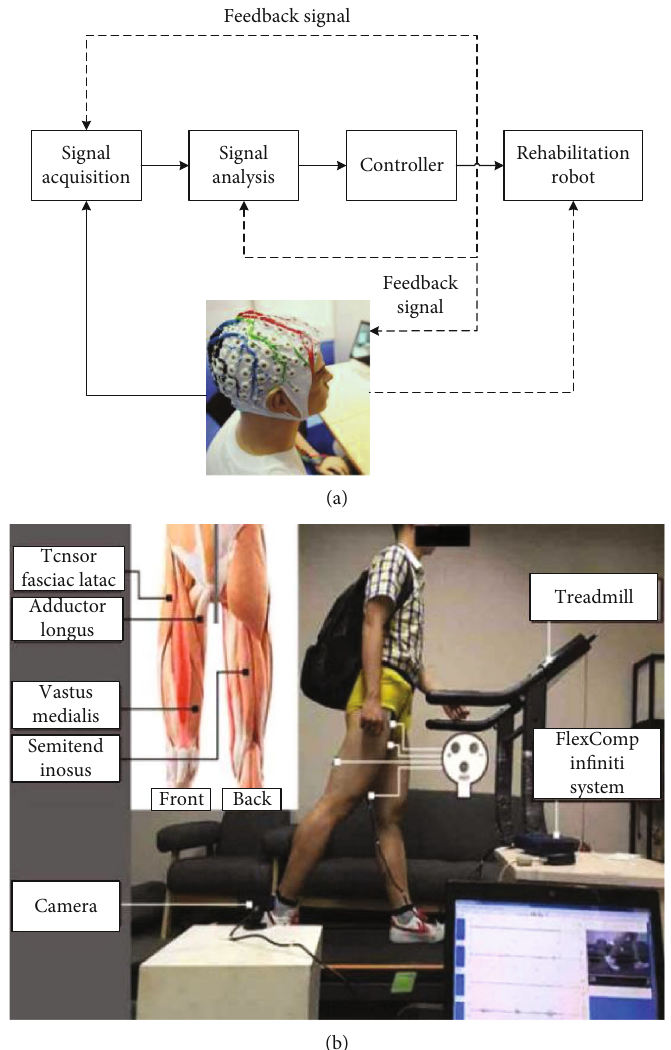
Figure 3: Interactive bioelectricity information acquisition methods. (a) Brain machine interface system block diagram [43]. (b) Surface electromyography (sEMG) information acquisition